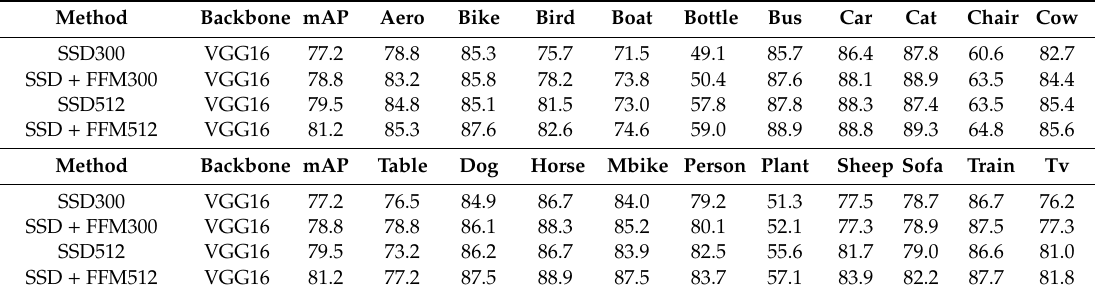
Table 2. Test results of SSD and SSD + FFM.